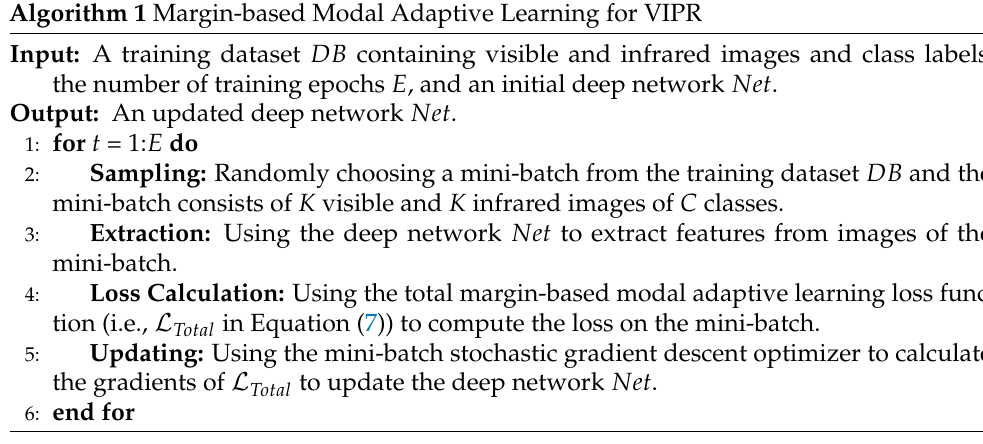
Algorithm 1 Margin-based Modal Adaptive Learning for